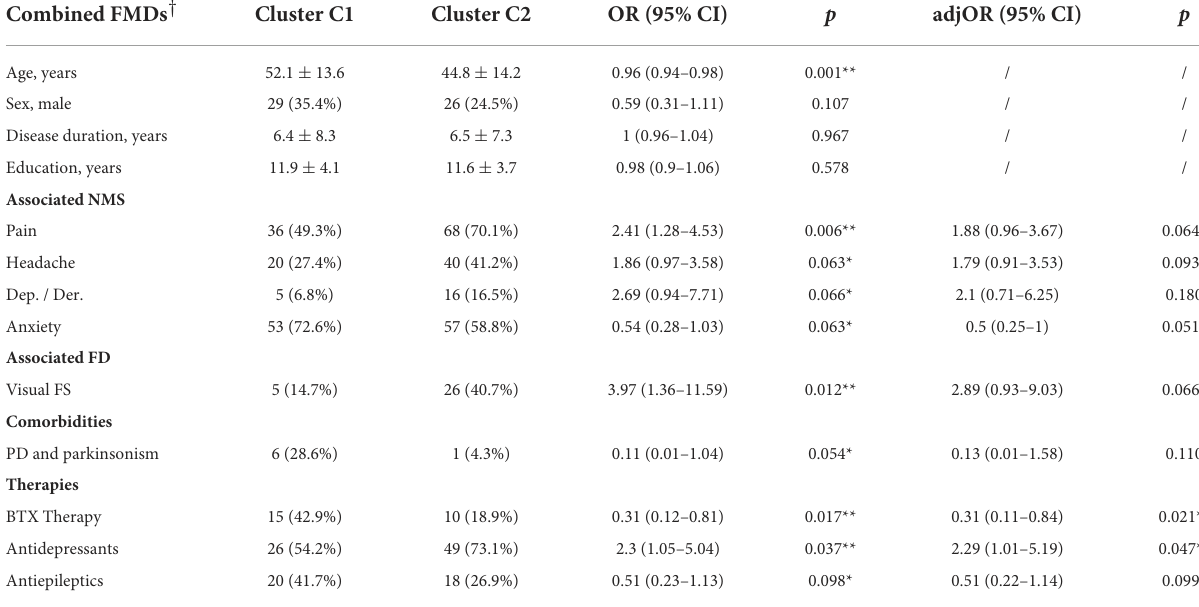
TABLE 2 Differences in evaluated clinical variables between the identified